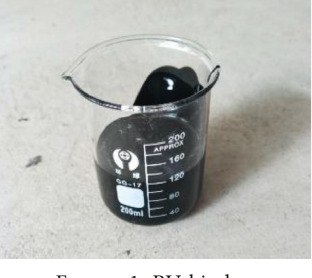
Figure 1: PU binder.